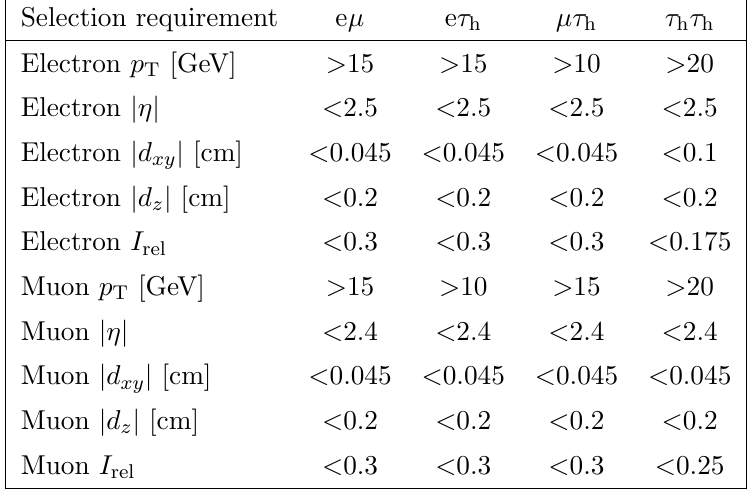
Table 2. Summary of requirements for identifying additional electrons and